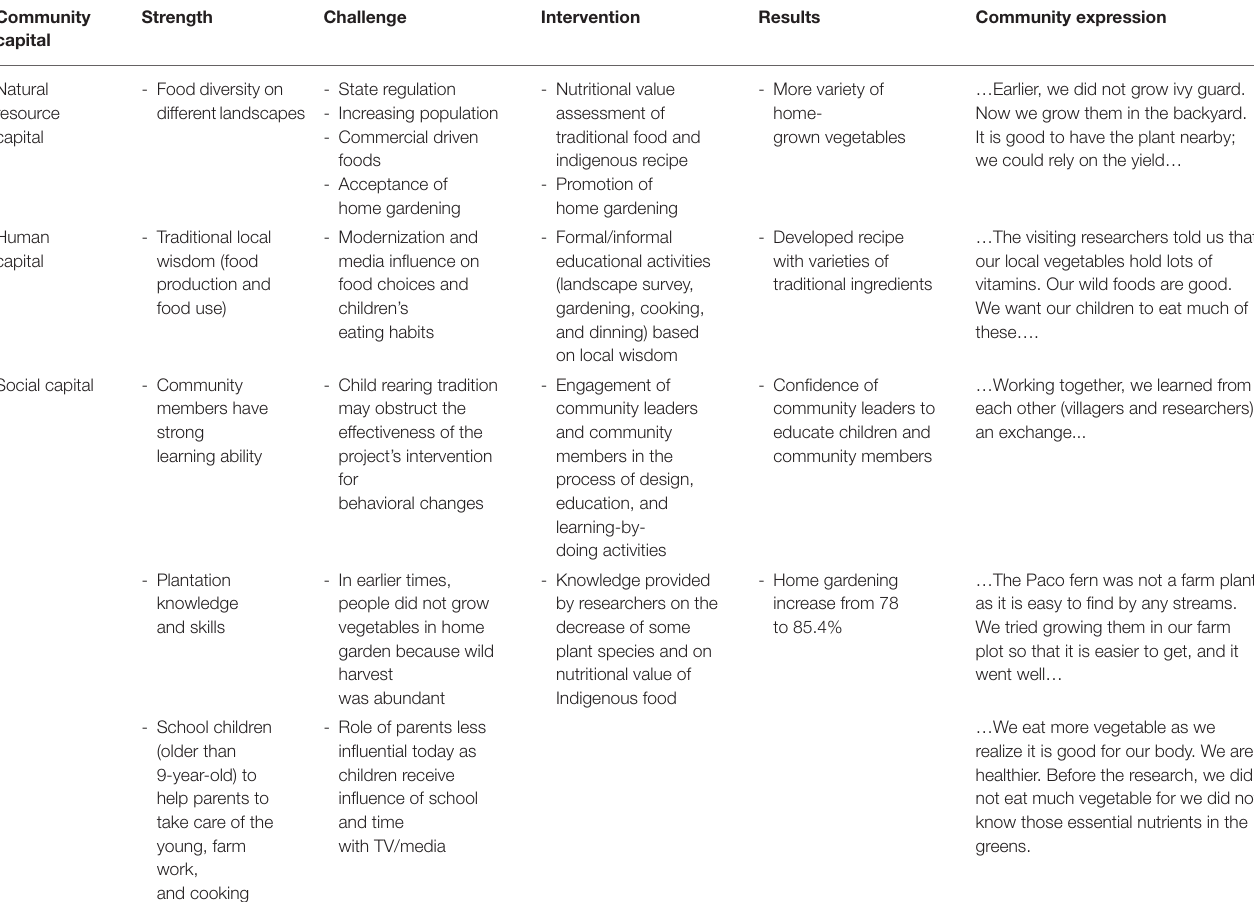
TABLE 6 | Summary of Karen natural resources capital, human capital, and social capital. Community Strength capital Natural